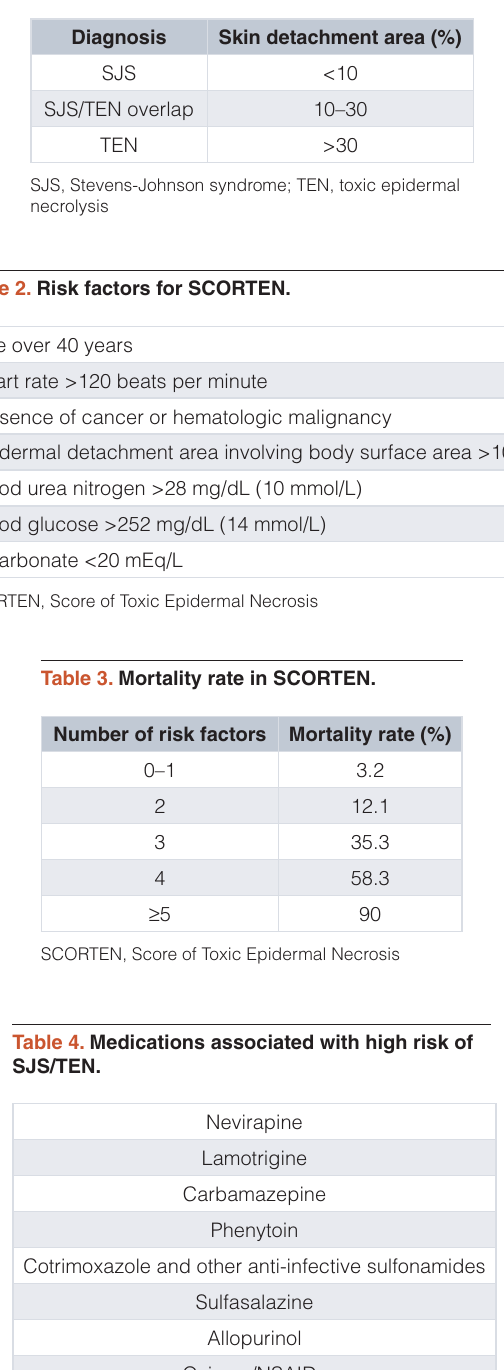
Table 1. Classification of SJS/TEN.